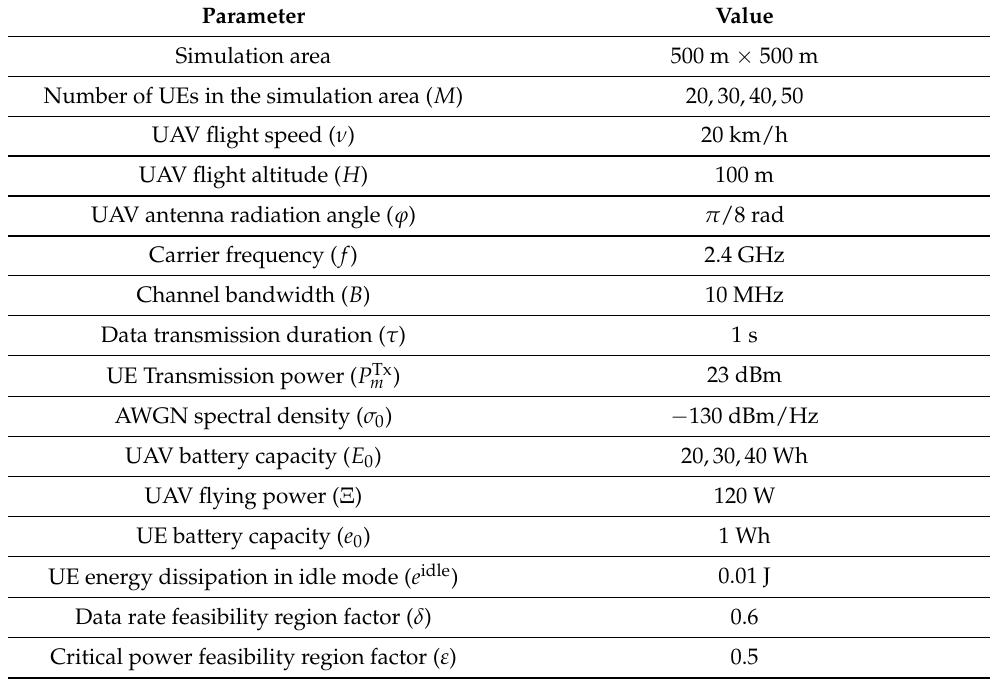
Table 1. Simulation parameters.